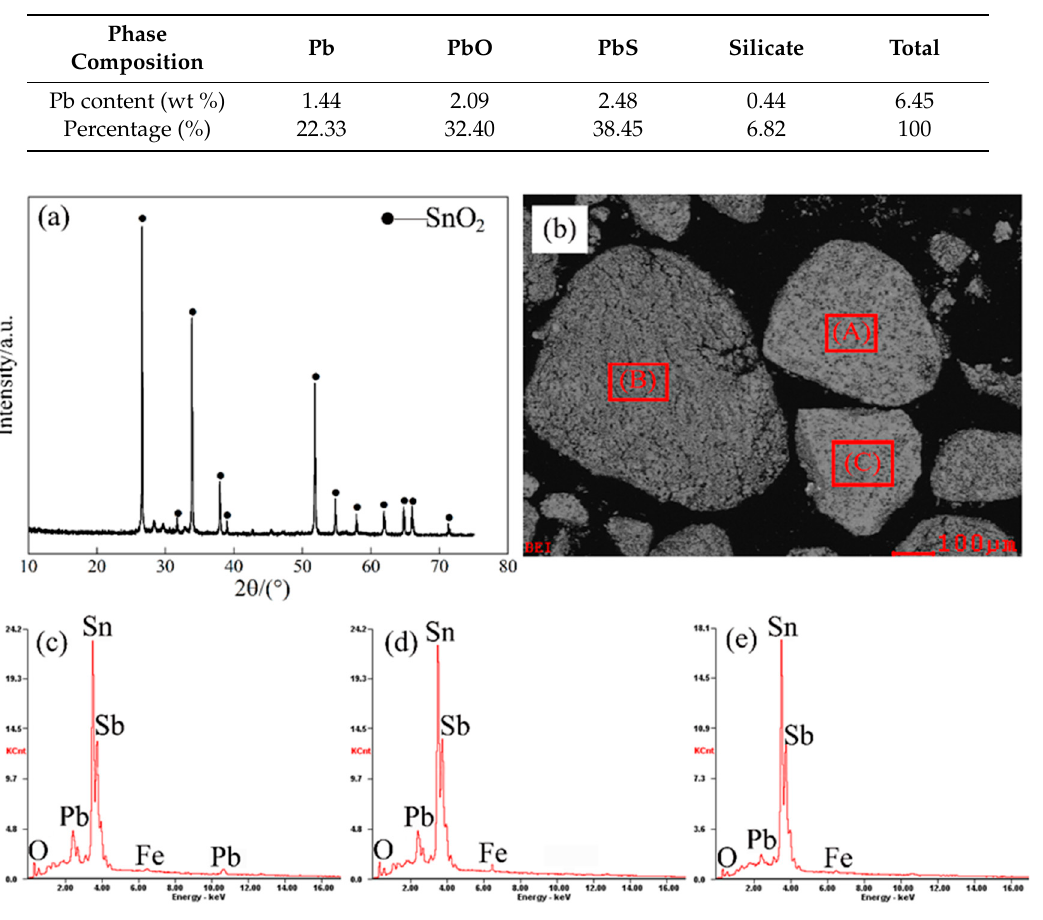
Figure 1. XRD pattern ( a ) and SEM image ( b ) of lead refining dross with energy dispersive spectrometry ( EDS) spectra at points A ( c ), B ( d ), and C ( e